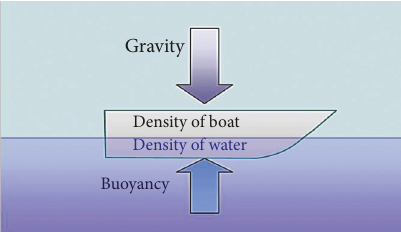
Figure 7: Overall view of the novel automated